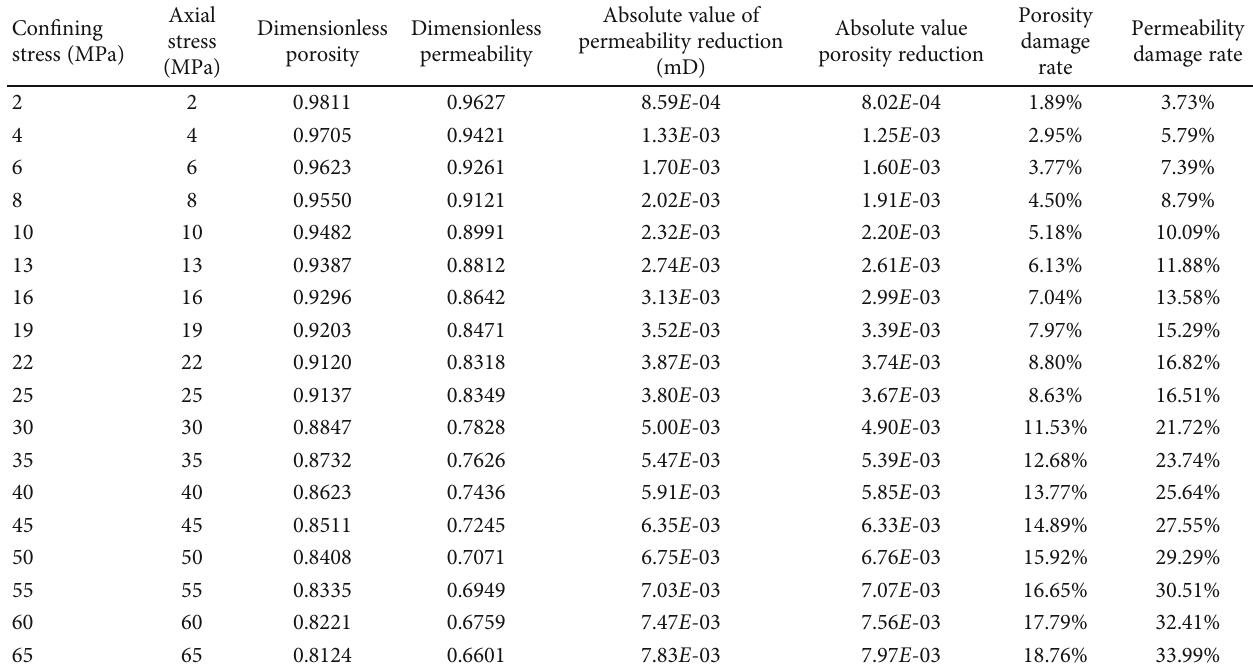
Table 3: Data of porosity and permeability damage rate under di ff erent con fi ning